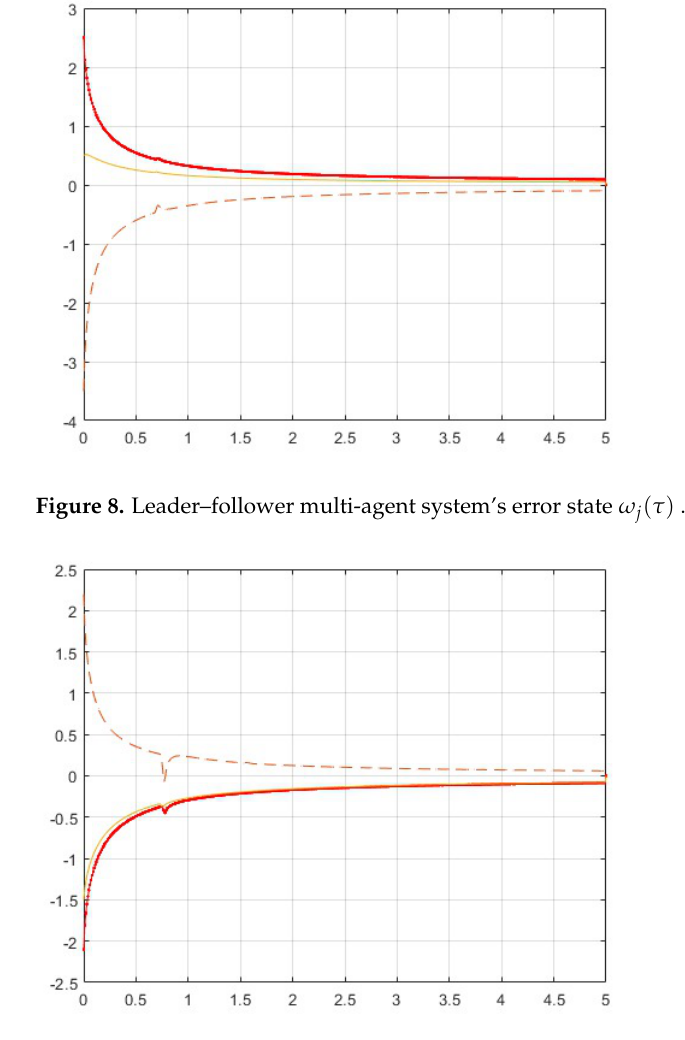
Figure 9. The leader–follower multi-agent system error states ω j ( τ )